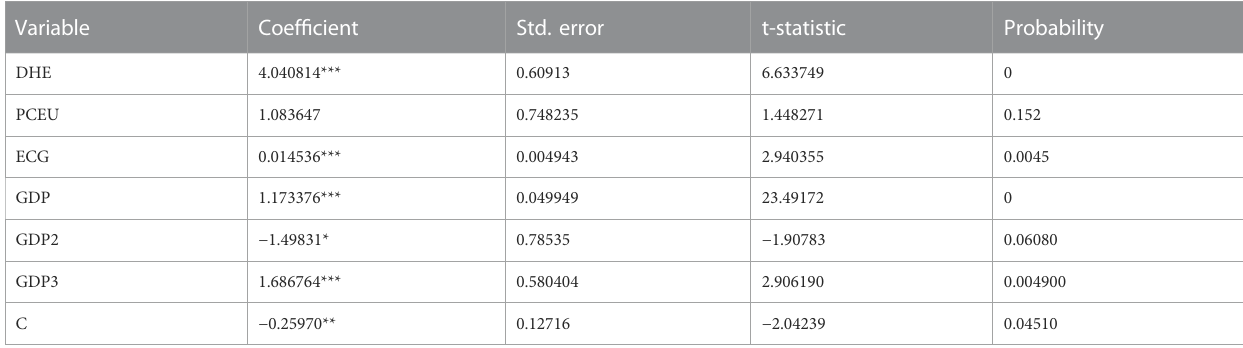
TABLE 5 Robustness testing through the CCR model.